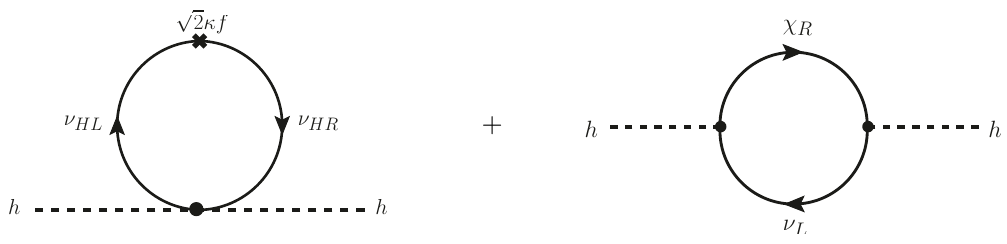
Figure 1 . Diagrams contributing to the Higgs mass. The mirror lepton exchange (left) cancels the mirror-singlet mixing contribution